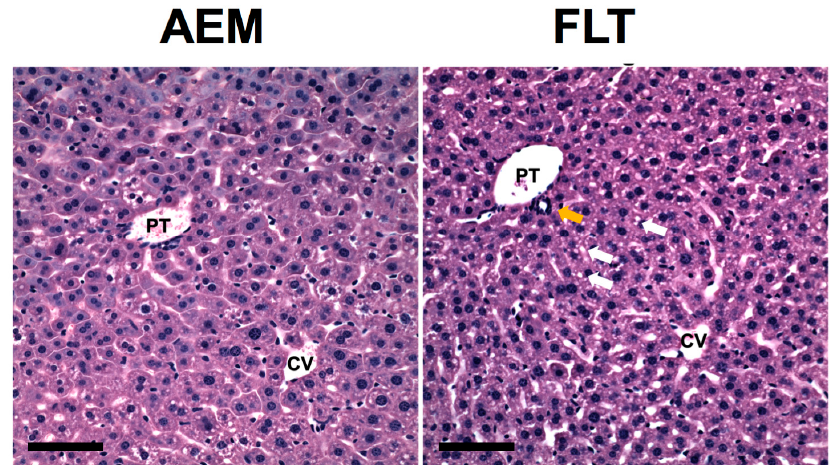
Figure 3. Increased steatosis and infiltration of inflammatory cells in livers from mice exposed to spaceflight. H&E staining was performed on fixed liver sections from n = 4–5 mice/group to investigate liver histology. Inspection of the H&E stained sections revealed that the AEM ground control mice had small cytoplasmic lipid droplets predominantly located in zone 2 whereas the FLT mice had an increase in slightly larger droplets distributed in a panlobular pattern. Multiple lipid droplets are indicated using white arrows. Furthermore, FLT mice showed increased accumulation of mononuclear inflammatory cells, particularly near portal ducts (yellow arrow). Representative images are shown from each group. PT = portal triad, CV = central vein. Scale bar = 100 μ m.